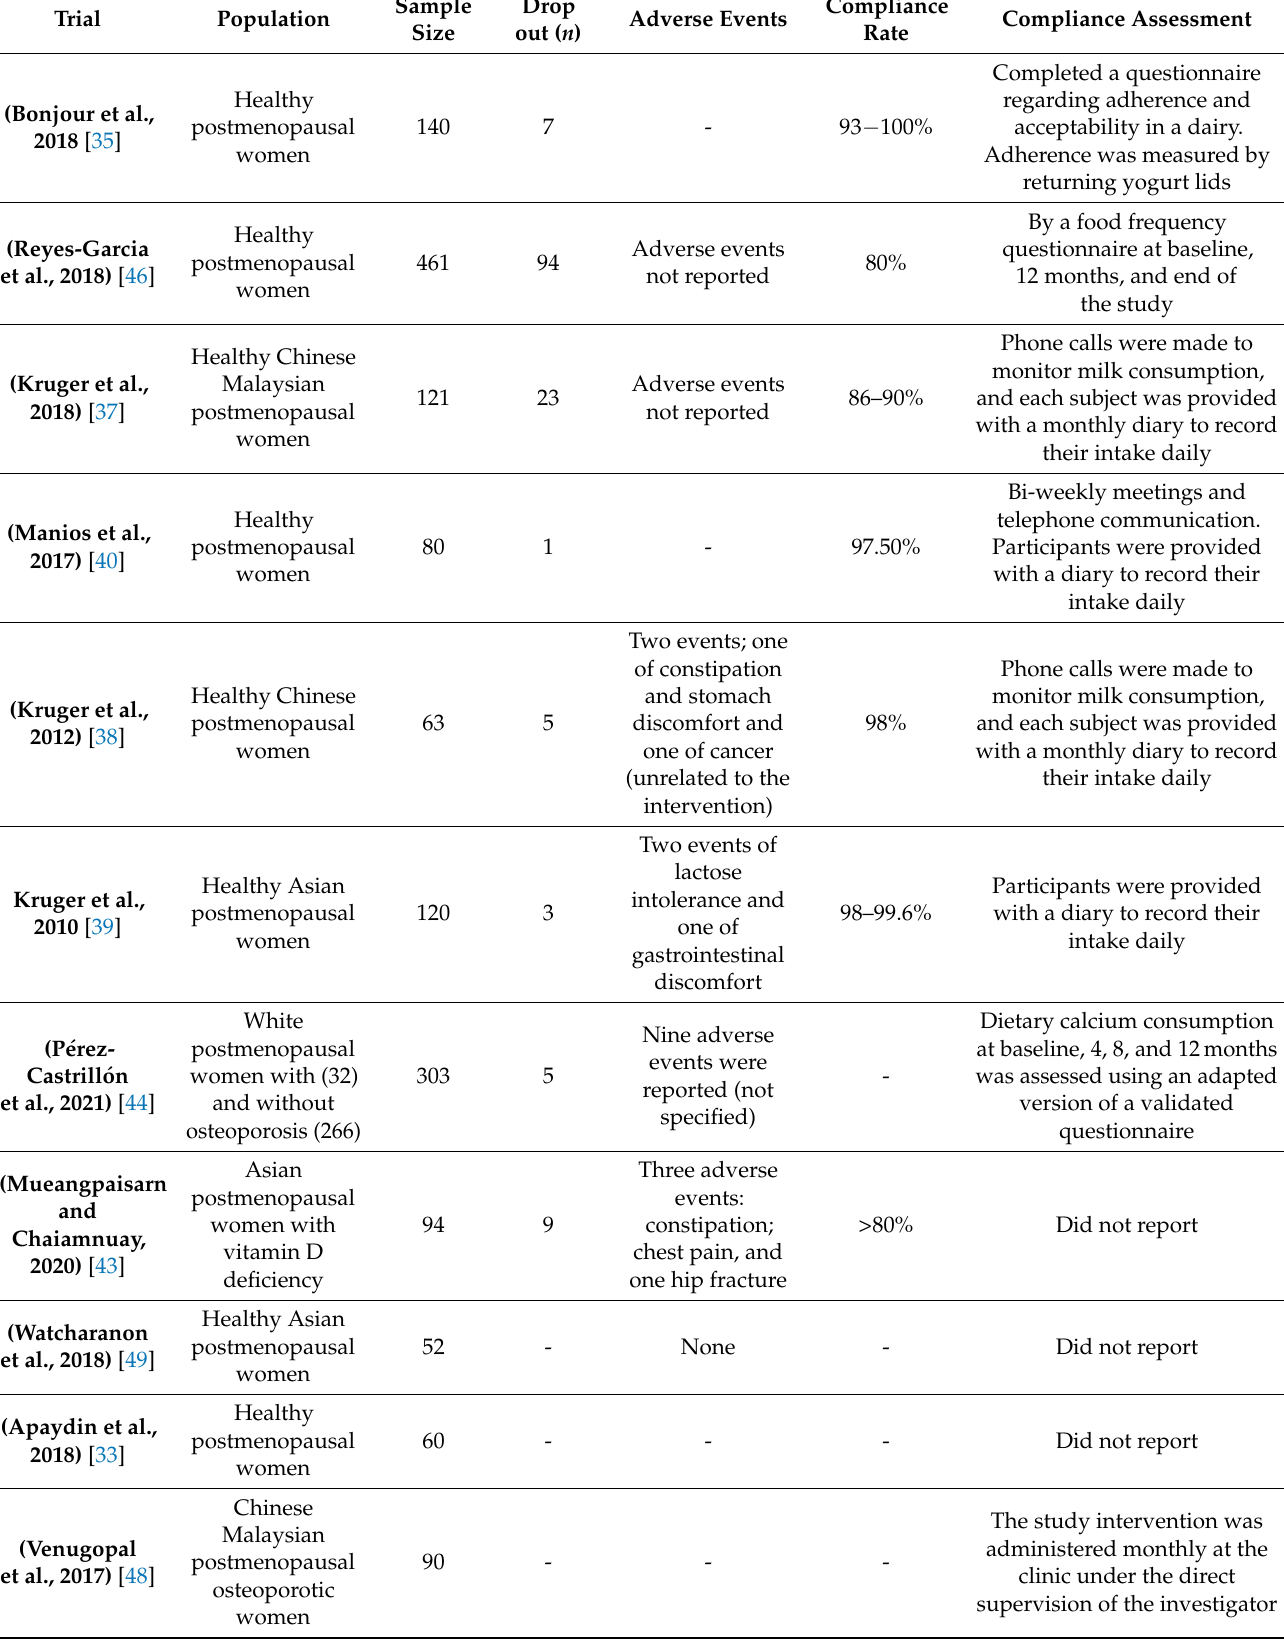
Table 2. The study participant